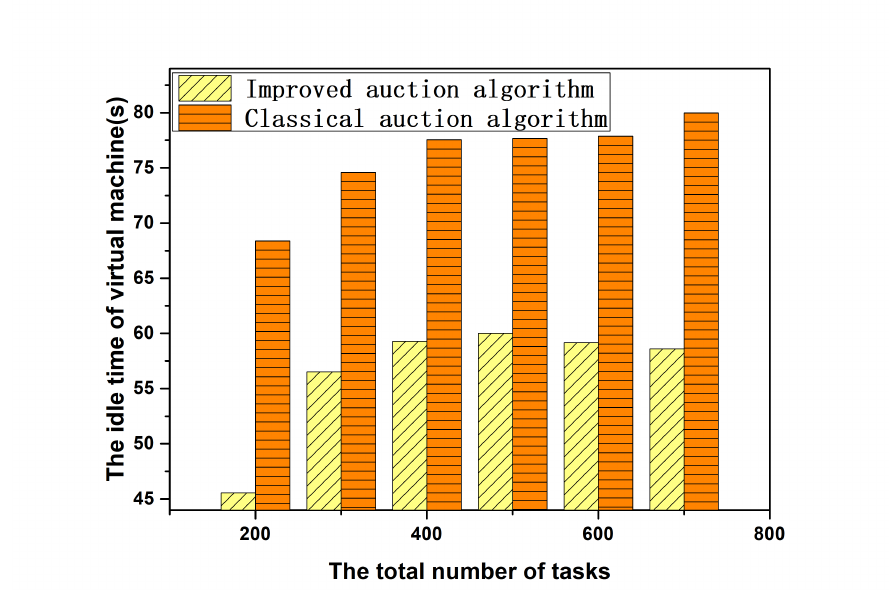
Figure 10. The idle time of the virtual machine under the different total number of tasks.